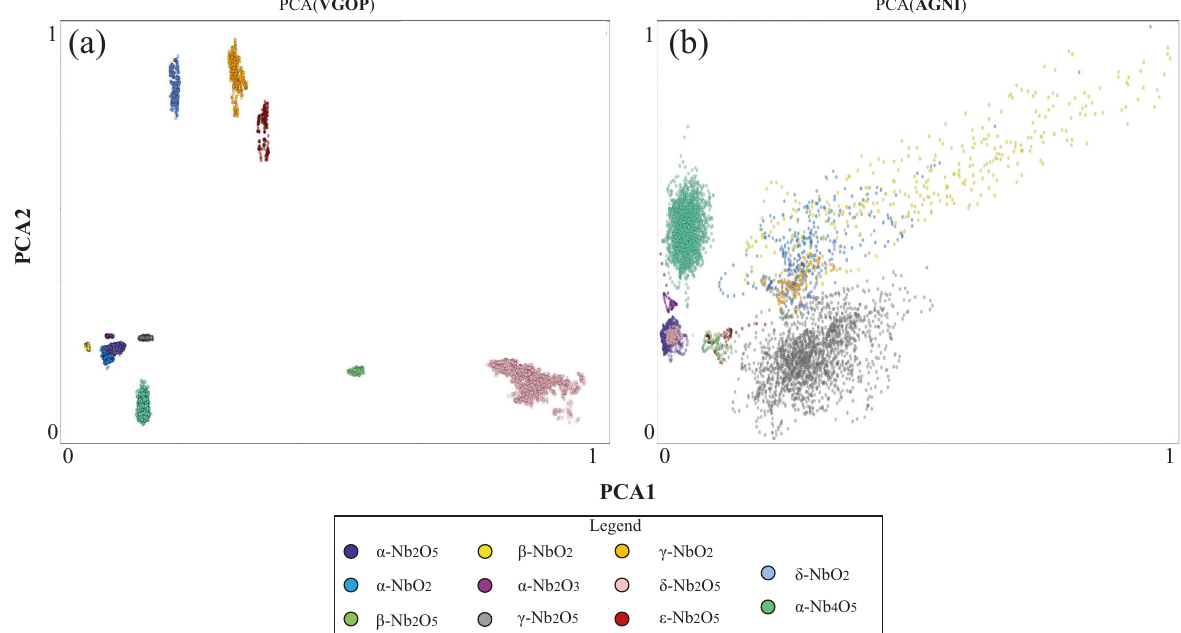
Fig. 8 Spatial clustering of Nb x O y between AGNI and VGOP. Comparison of the PCA reduction of the AGNI ( b ) and VGOP ( a ) generated feature vectors for various crystalline phases of niobium oxide. The inserted legend indicates the colors differentiating the phases. The PCA axes have been normalized and shifted to be all